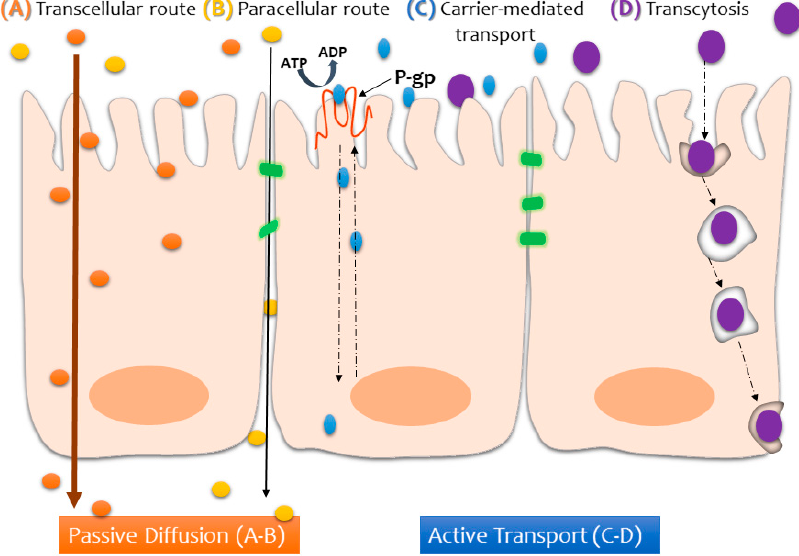
Figure 2. Schematic illustration of the possible transport pathways across the intestinal epithelium, depending on the nature of the compound being absorbed.